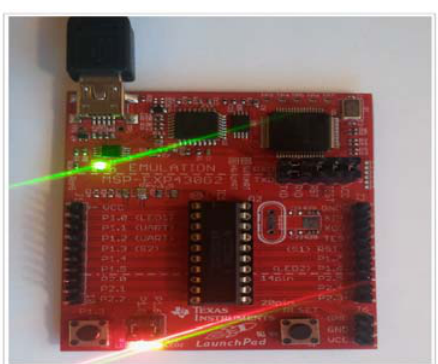
Figure 8. LED blinking.